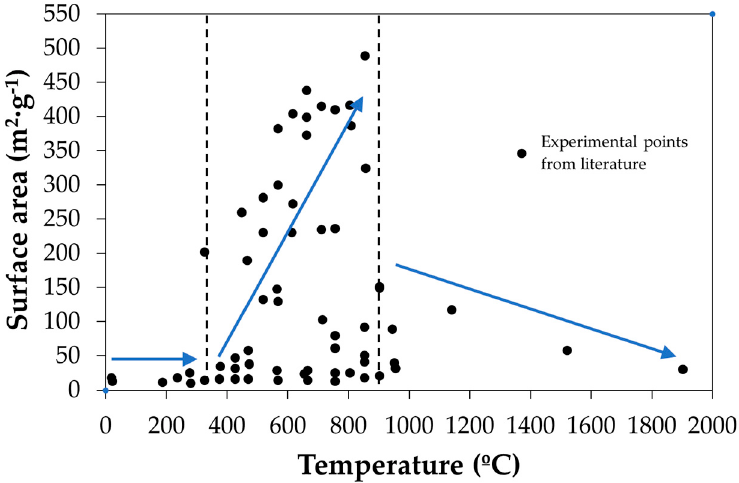
Figure 4. Evolution of the surface area of biochars obtained from different biomass resources with the carbonization temperature (adapted from [68], with permission from Elsevier, 2017).